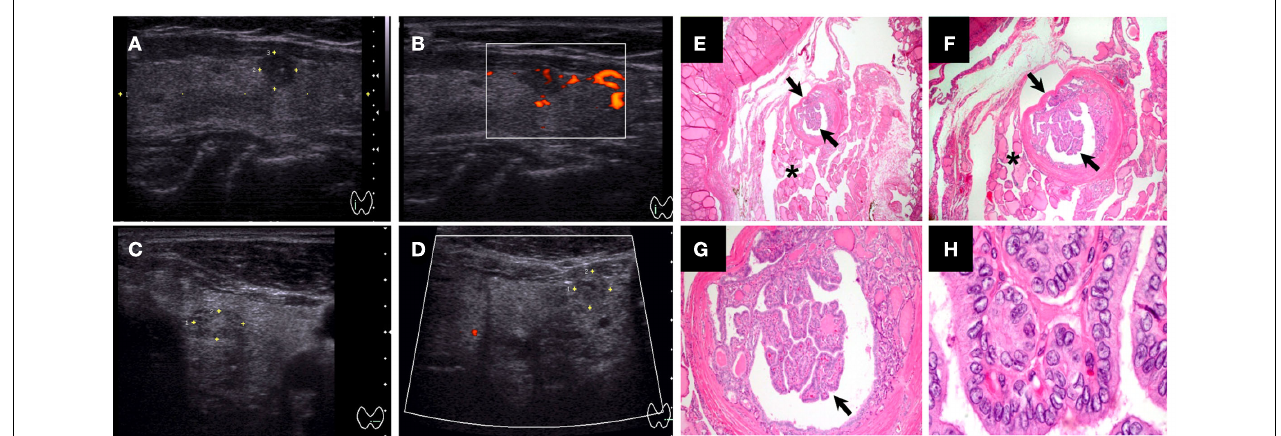
calcifications [also “taller than wider” in (D) ]. (E–H) Histological features of 2mm encapsulated PTMC with classical-type features in a multinodular goiter [arrows, (E–G) ]: papillary structure with fibrovascular stalk, nuclear grooves, and nuclear pseudo inclusions (H) .The tumor cells had pale eosinophilic cytoplasm with the characteristic vesicular to ground glass appearing nuclei (H) [Magnification: (E) 20 × , (F) 40 × , (G) 100 × , and (F) 1000 ×